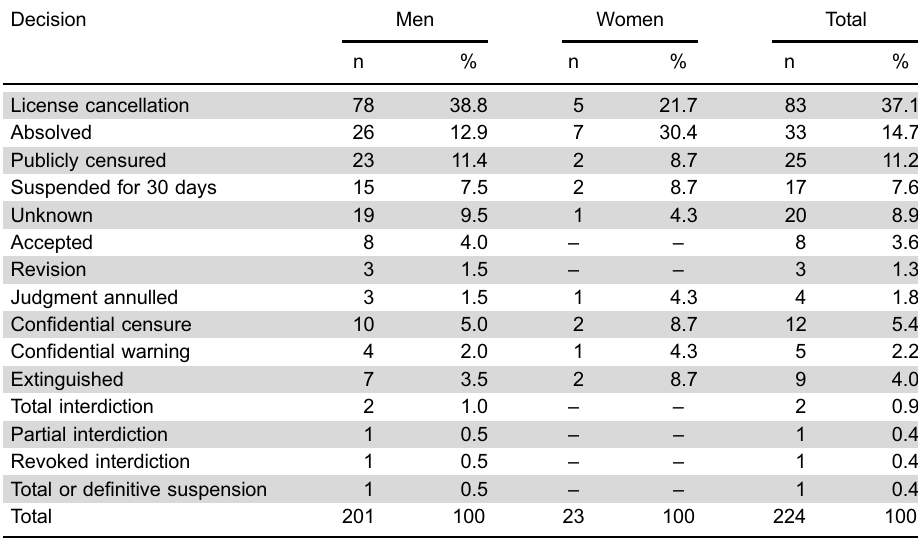
Table 5. Decisions of the Federal Council of Medicine by gender.